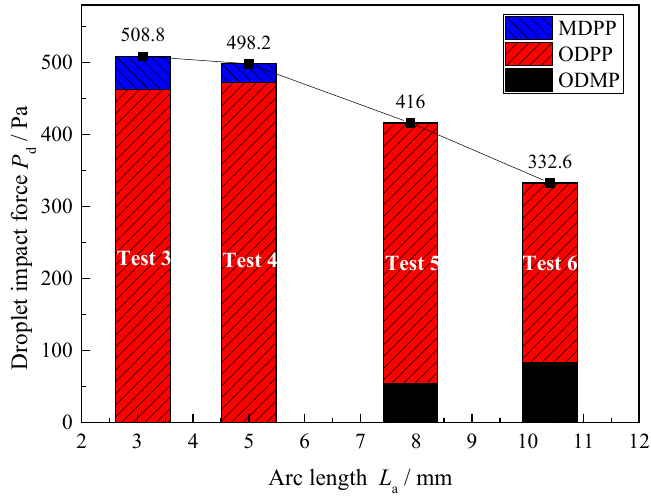
Figure 13. The average droplet impact force of projected transfer.